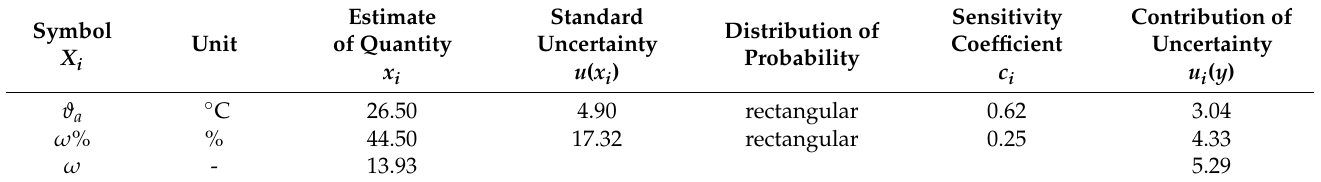
Table 1. Uncertainty budget ω .